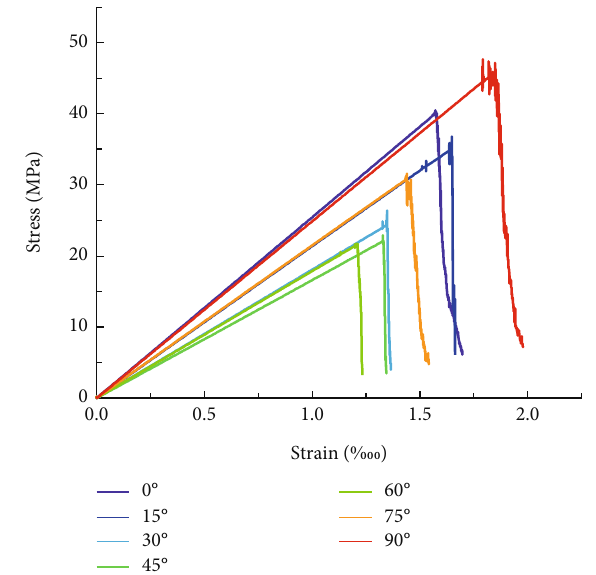
Figure 8: Stress – strain curves at di ff erent inclination angles.